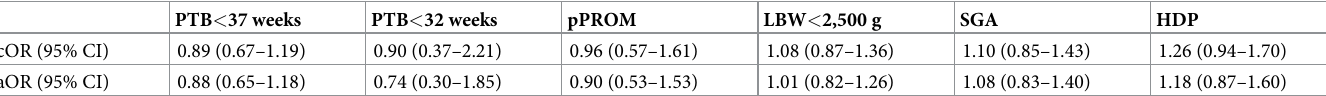
Table 3. Effect of CT infection on pregnancy outcomes (total